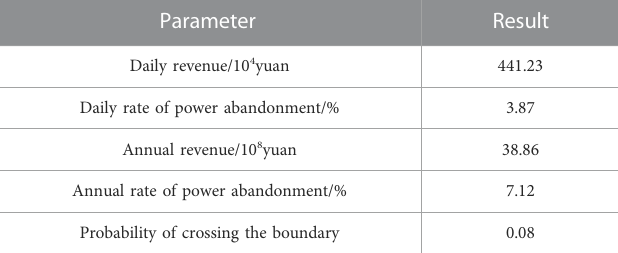
TABLE 1 Simulation results of the method in this